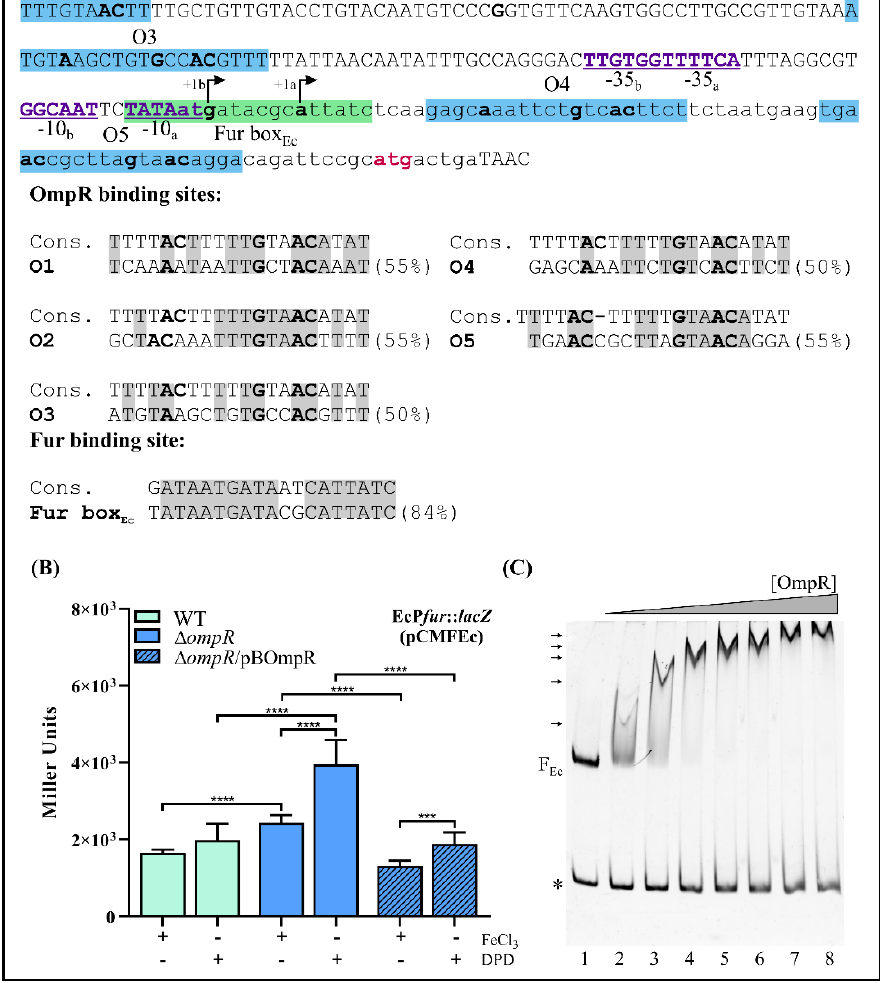
Figure 9. OmpR-dependent fur regulation in E. coli . ( A ) The fur promoter region of E. coli (based on 47 and 85). The nucleotide sequence from nt −284 to +12 relative to the first nucleotide of the fur ATG start codon. The putative OmpR-binding sites are highlighted by a blue background, while the Fur-binding site (Fur box Ec ) is highlighted by a green background. The translation start codon of fur is colored pink. The −10 and −35 elements of the fur promoter are in bold, underlined and colored purple. The transcription start sites of E. coli fur (a and b) and uof are indicated by +la, +lb and +1 uof , respectively. The lowercase sequence represents the uof ORF. The putative OmpR- and Fur-binding sites are shown aligned to the E. coli consensus sequences (% identity values are shown). Identical nucleotides in the compared sequences are shaded gray. In both the promoter region sequence and alignments, the nucleotides important for OmpR binding are in bold. ( B ) Expression of a plasmid- encoded EcP fur :: lacZ transcriptional fusion (pCMFEc) in E. coli strains BW25113 (WT) and JW3368- 1 ( ompR ) and complemented strain JW3368-1/pBOmpR (expresses OmpR from Y. enterocolitica Ye9). β-Galactosidase activity was measured in strains grown at 37 °C to early stationary phase in LB medium, under iron-limiting (150 µM DPD) or iron-replete (10 µM FeCl 3 ) conditions. The pre- sented data represent mean activity values with SD from three independent experiments carried out in triplicate. Significance was calculated using one-way ANOVA (*** p < 0.001, **** p < 0.0001). ( C ) EMSA of the interaction between Y. enterocolitica OmpR-His 6 and the E . coli fur promoter region (F Ec ) depicted in Figure 9A. The 304-bp fur promoter fragment F Ec and the 211-bp fragment of 16S rDNA (*, from Y. enterocolitica Ye9) were incubated together in reaction mixtures without protein (lane 1) or with an increasing amount of purified OmpR: 0.65 (lane 2), 1.3 (lane 3), 1.95 (lane 4), 2.6 (lane 5), 3.25 (lane 6), 3.9 (lane 7), 4.55 µM (lane 8). The OmpR/DNA complexes were resolved on a